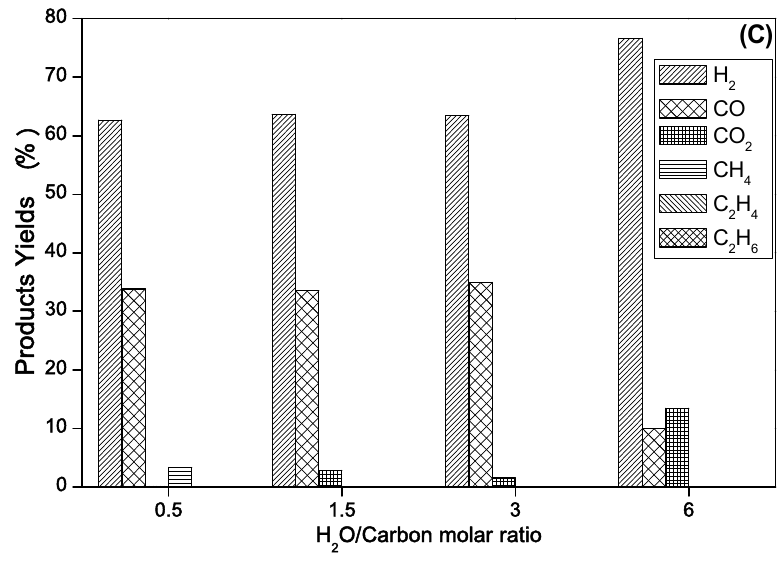
Figure 9. Effect of H 2 O/Carbon (S/C) feed molar ratio on product yield at 400 °C ( A ); 600 °C ( B ) and 800 °C ( C ) over 20 wt.% Co/CeO 2 catalyst. Reaction conditions: m cat = 250 mg, F T = 150 cm 3 /min.